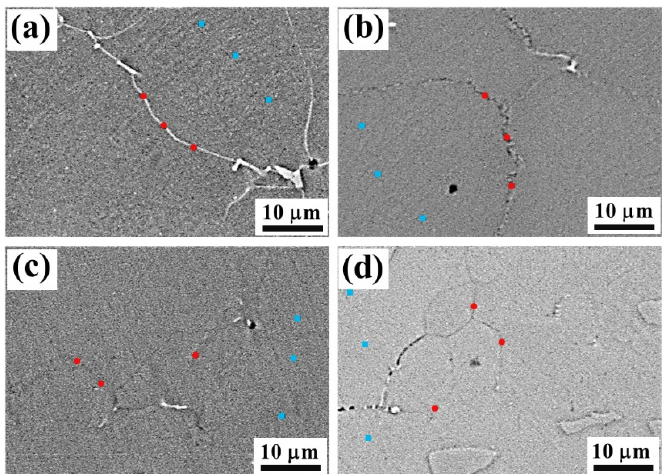
Figure 11. Element content test location on grain boundaries (red points) and in the austenitic phase matrix (blue points) with different cooling rates: ( a ) 1.69 °C/s; ( b ) 2.01 °C/s; ( c ) 5.87 °C/s; ( d ) 10.28 °C/s.